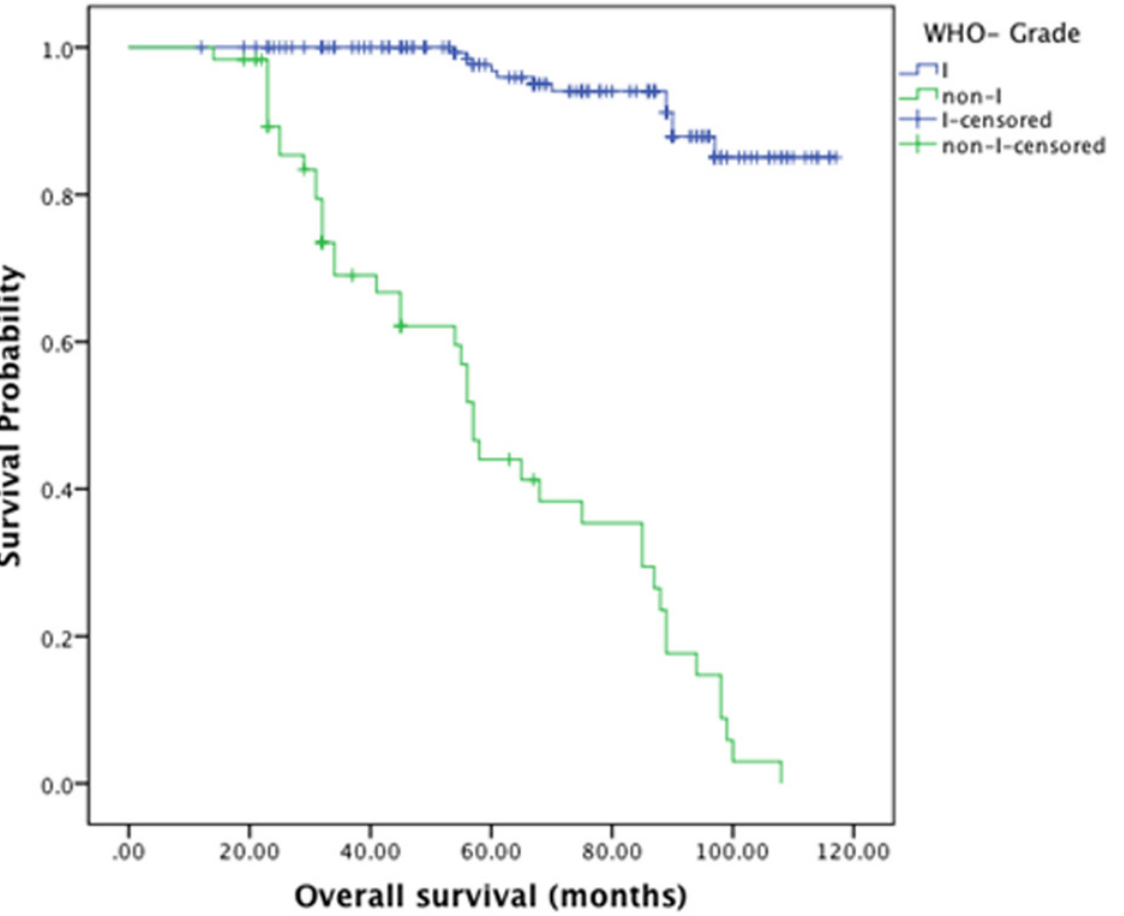
Fig 3. Kaplan-Meier Curve for Survival analysis for WHO grade I and non-grade I